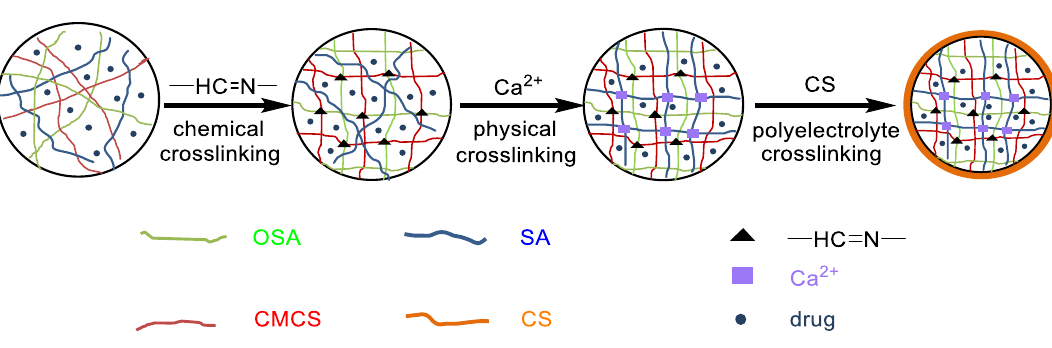
Figure 2. Preparation route of membrane-controlled interpenetrating network (IPN)